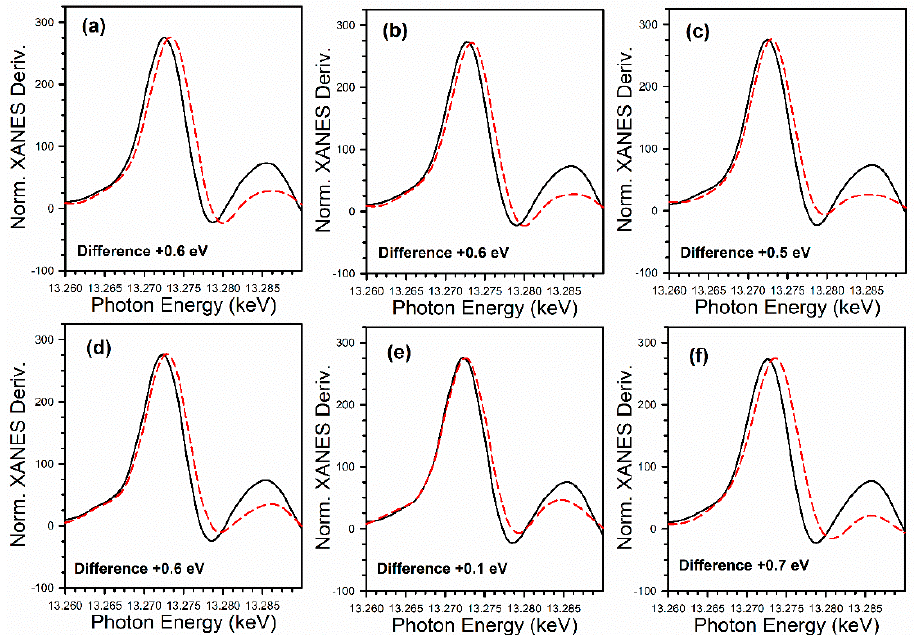
Figure 16. XANES derivative spectra at the Pt L 2 edge that are normalized to the height of the Pt metal foil of (solid black line) Pt metal foil reference and catalysts, including ( a ) 2% Pt/ZrO 2 , ( b ) 2.9% Cs-2% Pt/ZrO 2 , ( c ) 4.8% Cs-2% Pt/ZrO 2 , ( d ) 5.8% Cs-2% Pt/ZrO 2 , ( e ) 10.4% Cs-2% Pt/ZrO 2 , ( f ) 14.5% Cs-2% Pt/ZrO 2 .